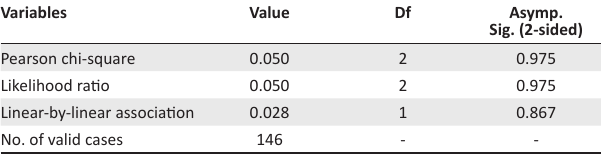
TABLE 2a: Marketing and supplies assistance: chi-square tests.